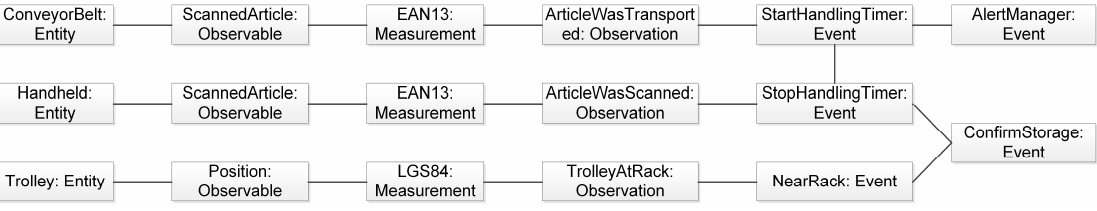
Figure 13. Exception “ConfirmStorage”.